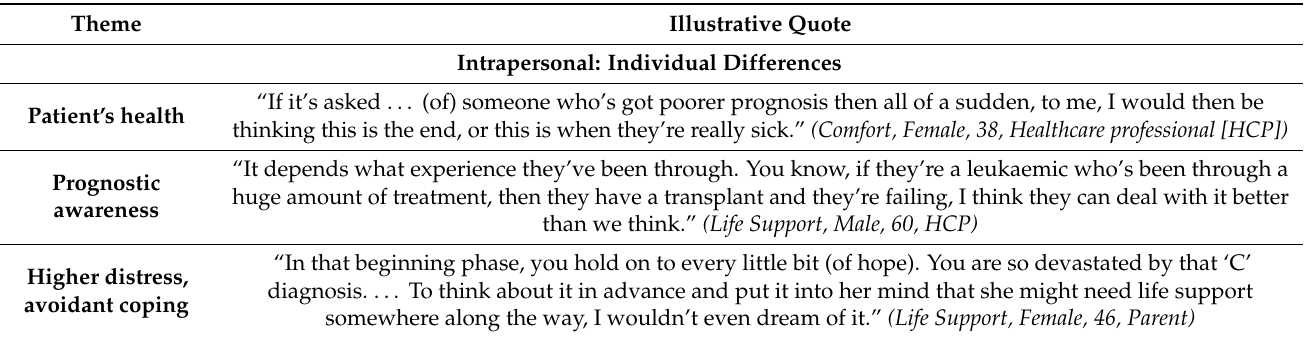
Table 4. Selected illustrative quotes reflecting sources of stressfulness in completing Voicing My